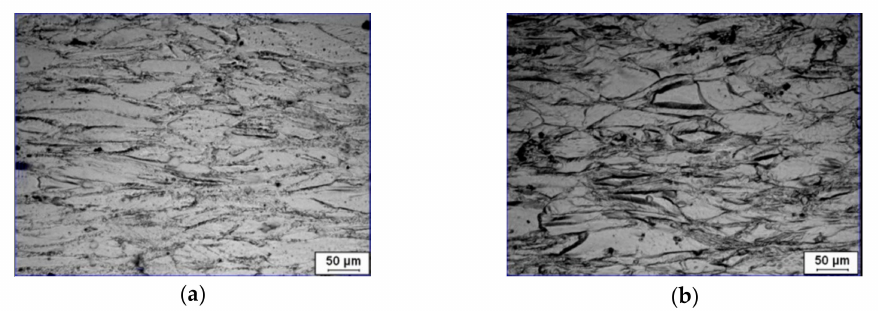
Figure 3. Optical micrographs of the deformed superalloy at the deformation temperature of 1193 K and strain rates of: ( a ) 0.1 s − 1 ; ( b ) 1 s − 1 (at the strain of